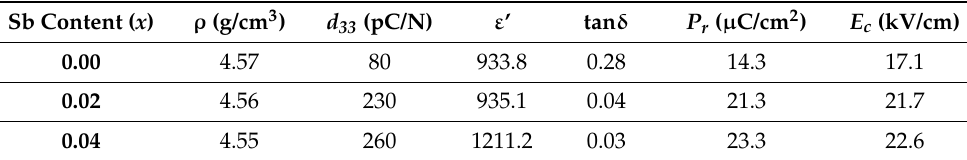
Table 1. Real permittivity ( ε ’), tan( δ ), remnant polarization ( P r ), and coercive field ( E c ) of KNL − (N 0.9 − x TS x ) ( x = 0.00 to 0.04) sintered samples measured at RT. Dielectric values were deter-